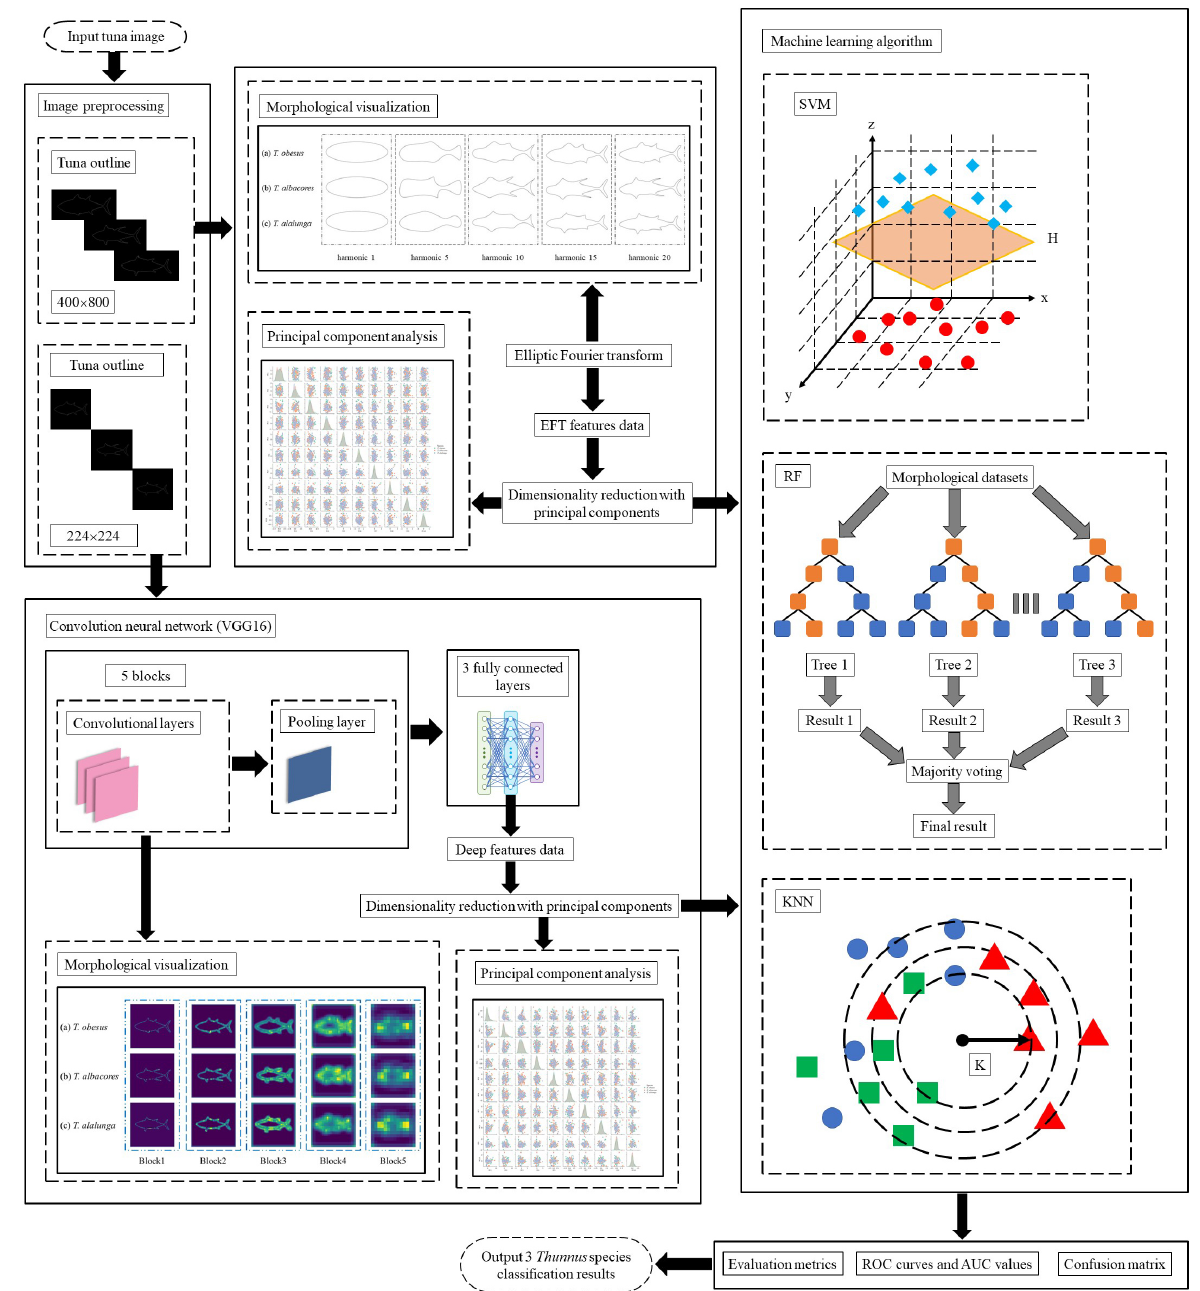
Figure 2. Flowchart of morphological characteristic identification based on machine learning